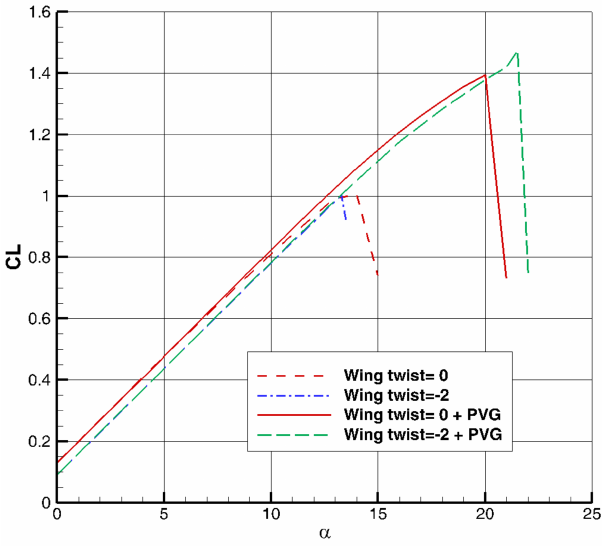
Figure 19. Effect of wing twist on the PVG